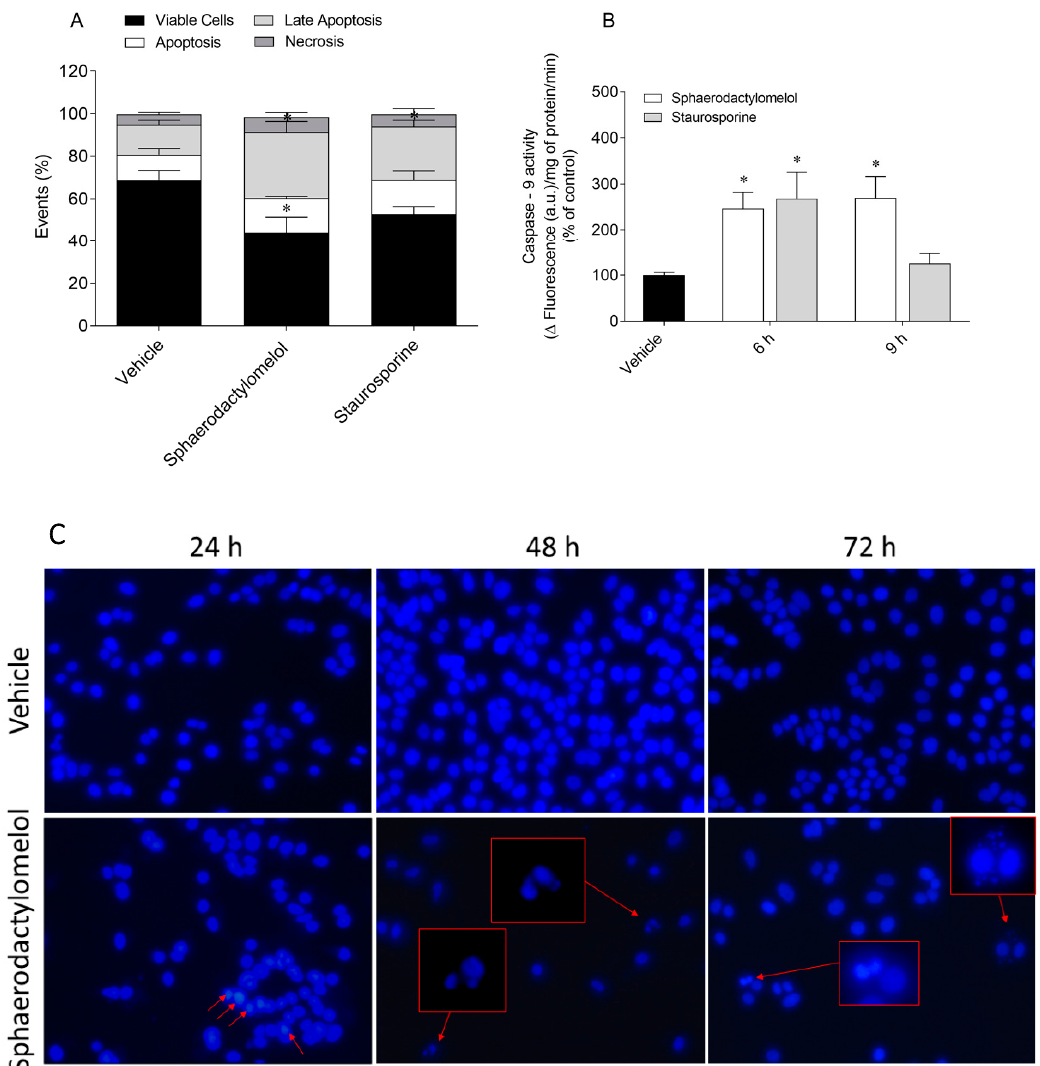
Figure 4. Sphaerodactylomelol effects on MCF-7 cells apoptosis biomarkers ( A ) externalization of phosphatidylserine, ( B ) Caspase-9 activity, and ( C ) DNA condensation and fragmentation. Values represent the mean ± SEM of three or four independent experiments. Symbols represent significant differences ( p < 0.05) when compared to: * control. Images of 4 ′ ,6-diamidino-2-phenylindole (DAPI) stained cells were obtained using inverted fluorescence microscope at ×400. Arrows indicate alterations in DNA as comparing with control. The images are representative of one well of each situation tested.